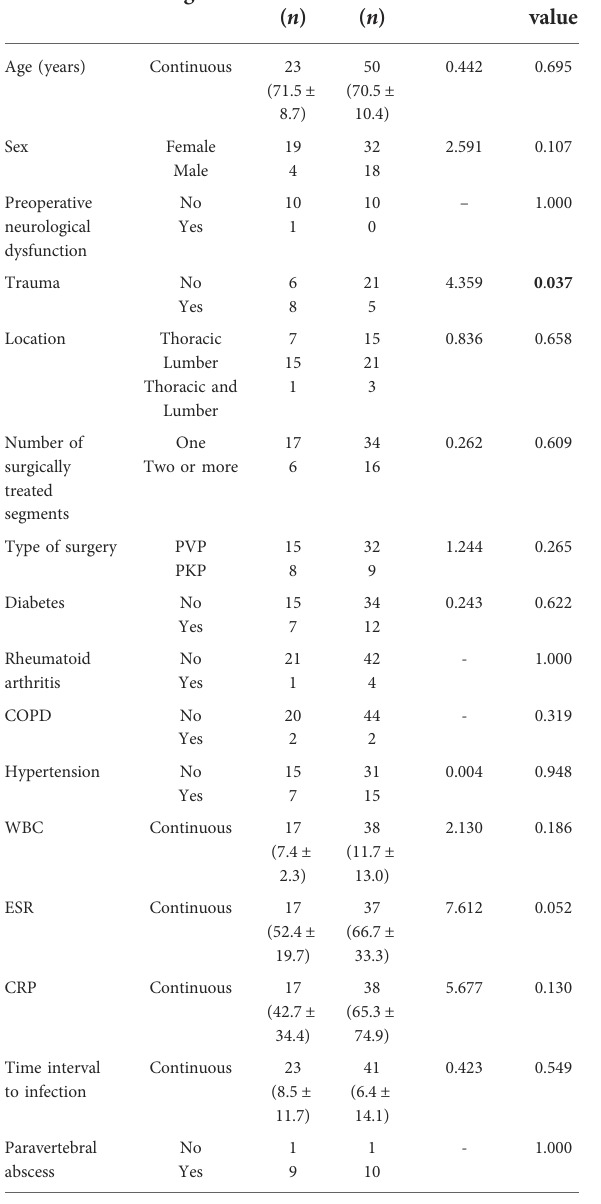
TABLE 3 Comparison of clinical features between TS and NTS group.